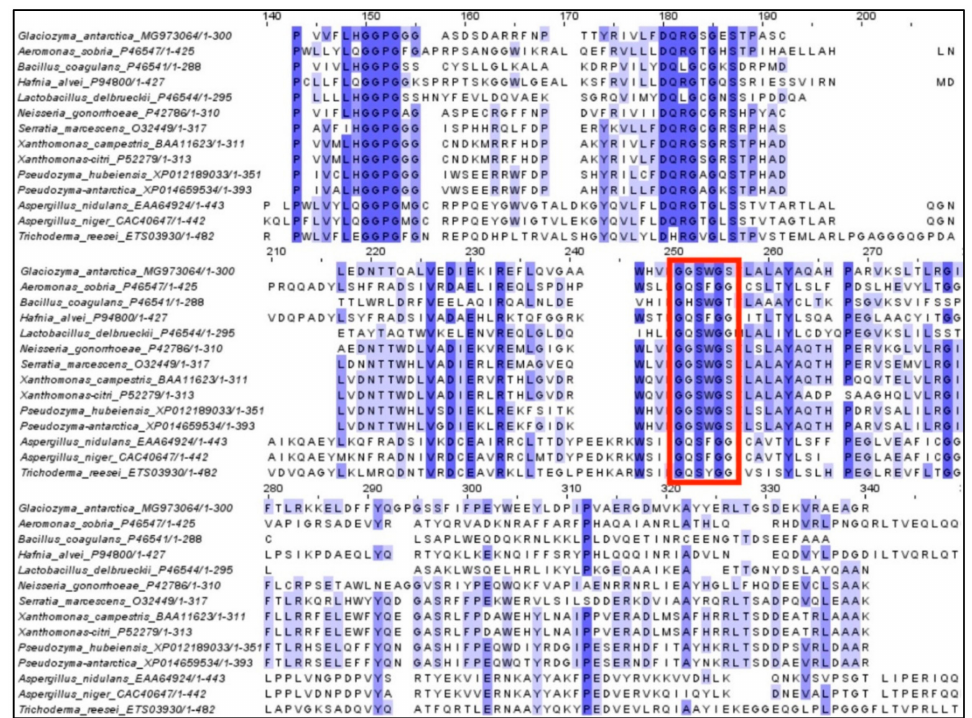
Figure 1. Multiple sequence alignment of catalytic domains of proline iminopeptidases from several monomeric and multimeric sequences obtained from the NCBI. The conserved motif is highlighted with a red